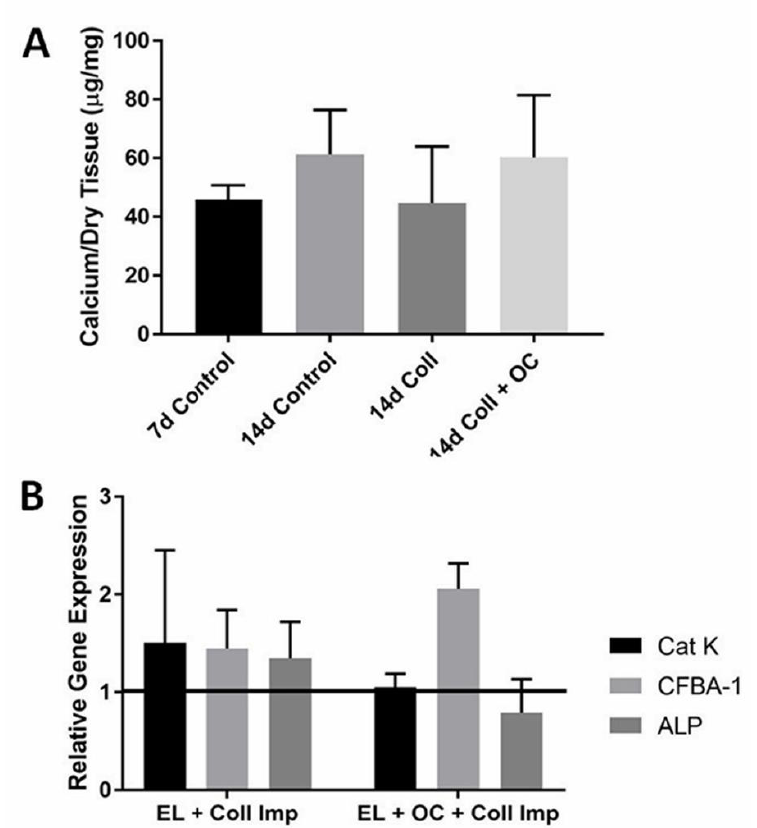
Figure 2. ( A ) The graph depicts calcium per dry tissue in µ g/mg for control groups, collagen implant, and collagen implant with OCs included. OCs delivered by collagen gel were ineffective for the reversal of elastin calcification ( n = 4). ( B ) In the second image, gene analysis results vary but the variance was not enough to affect calcification or show any significant difference, looking specifically at the Cat-K, CFBA-1, and ALP genes. Data were analyzed with ANOVA and Student’s t -test, with p < 0.05.